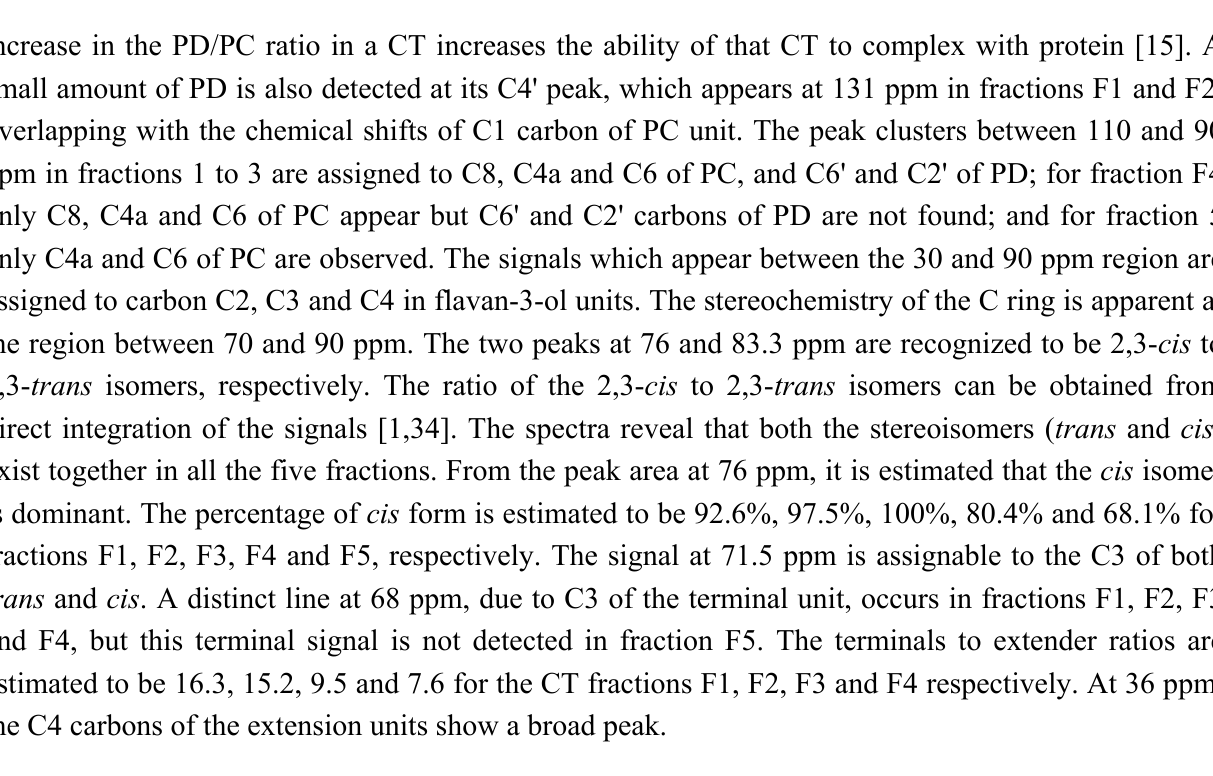
Figure 4. 13 C-NMR (125 MHz) spectra of CT fractions F1, F2, F3, F4 and F5 from LLR in DMSO- d ; DMSO- d , dimethyl- d sulfoxide. Identity of the structures: R 6 6 6 propelargonidin (PP); R =OH, R =H, procyanidin (PC); and R 1 2